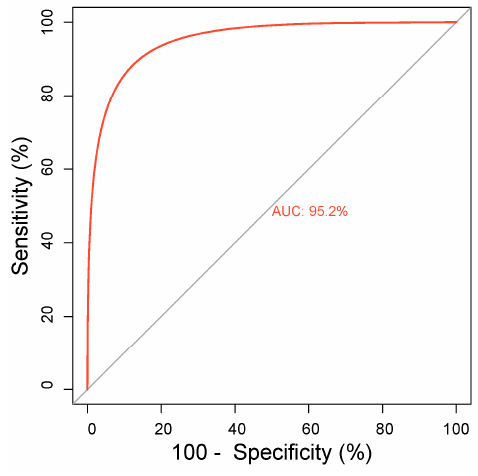
Figure 24. ROC Curve of ResNet Model.